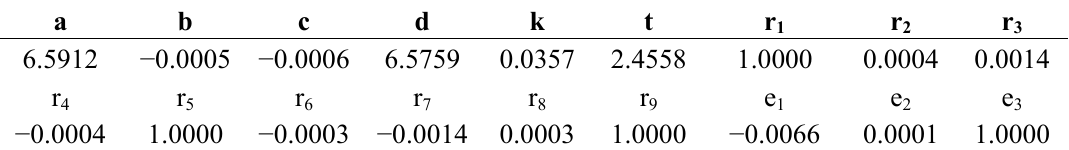
Table 4. Model parameters calibrated for one product of type